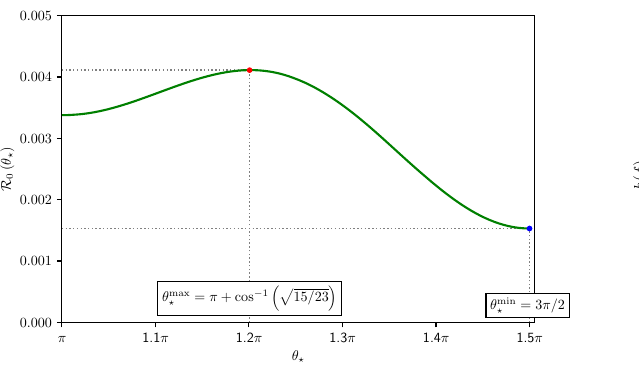
(cid:5) (cid:4) (cid:5) (cid:4) / 1920 π 2 , 29 + 150cos 2 θ (cid:14) − 115cos 4 θ (cid:14) Fig. 5 A plot of h ( f ) (red solid line) for GWs from a source with (cid:5) (cid:4) √ M ∼ 10 9 M (cid:17) , R o ∼ 2 × 10 11 M (cid:17) and r ∼ 10 10 ly, detected by means of 15 / 23 and 3 π/ 2, respectively amillisecondpulsarwith τ o ∼ 10 − 3 s.Itiscomparedwiththesensitivity curves for EPTA (black dotted line), IPTA (black dashed line) and SKA (black dash-dotted line) (taken from Ref. [22])